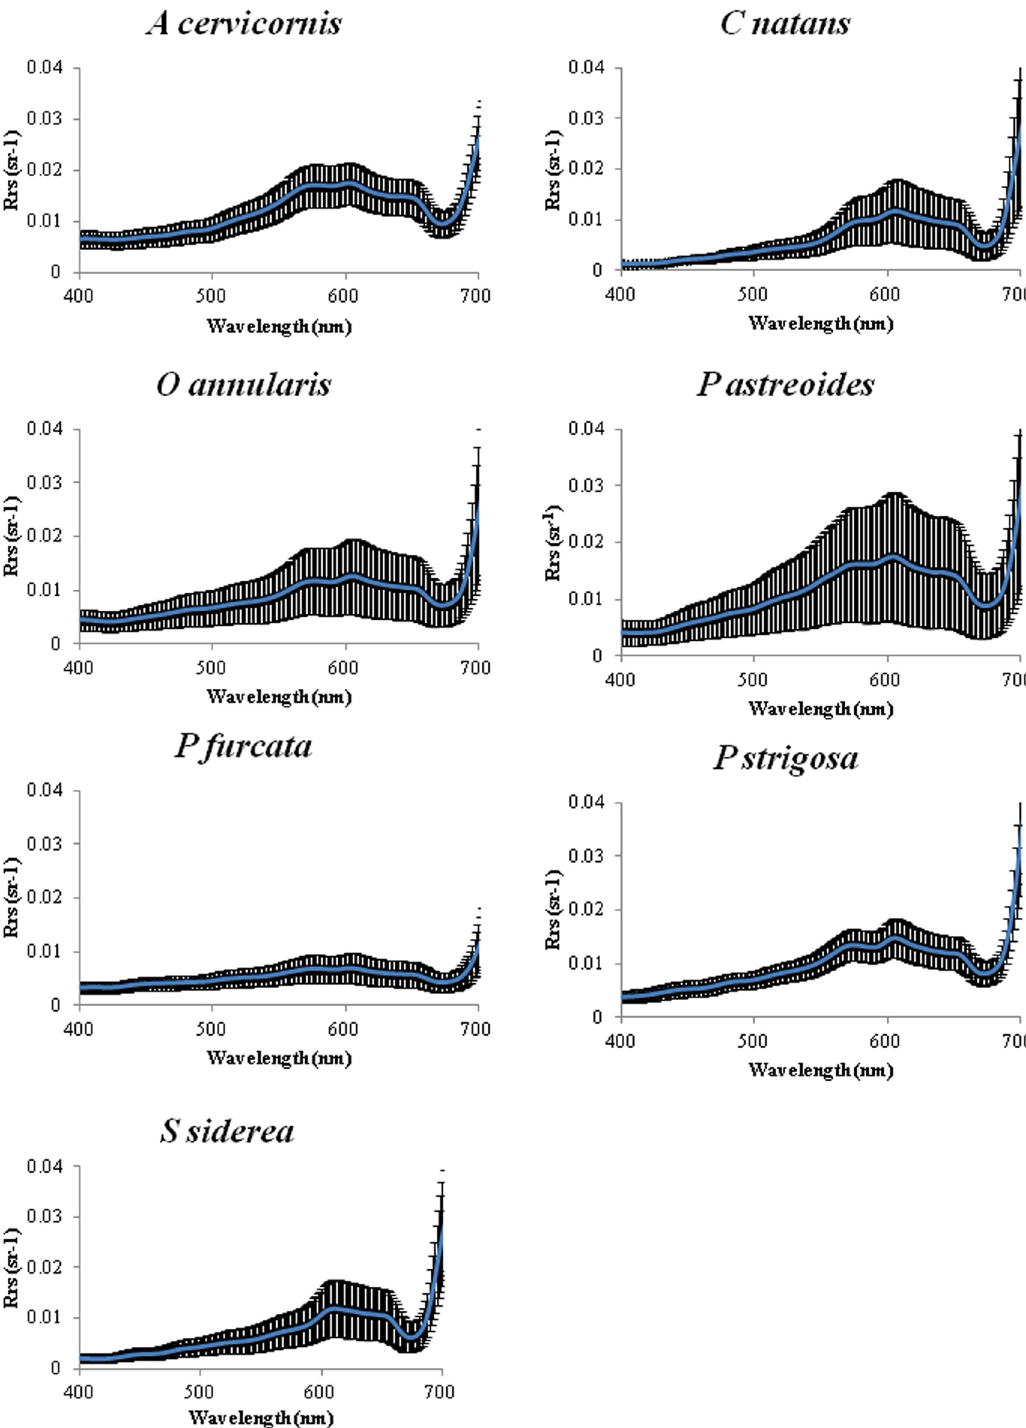
Fig 5. Remote sensing reflectance for all seven species. The blue line represents the average Rrs with ± 1SD shown as the black shadow. n = 5 for each species.